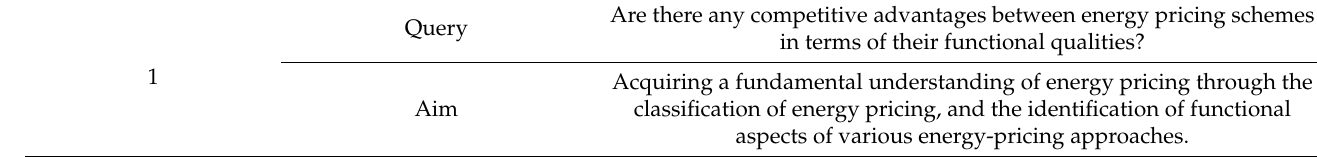
Table 2. Research queries and